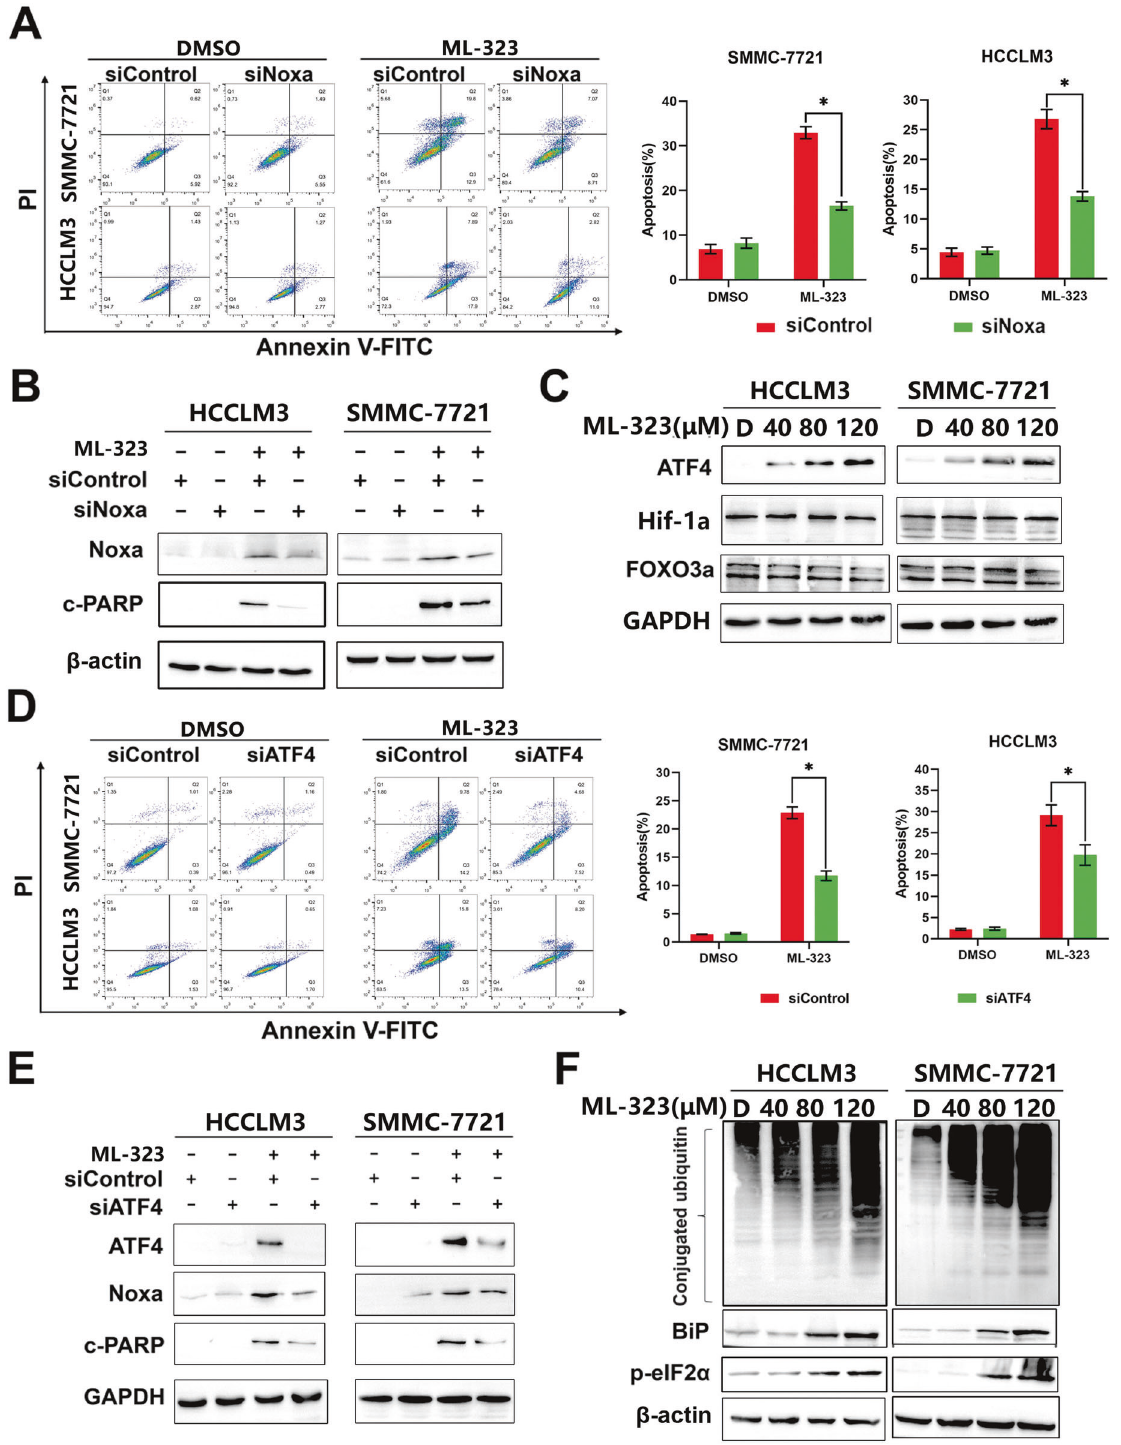
Fig. 3 ML-323 induces hepatocarcinoma cancer (HCC) cell apoptosis via the ATF4-Noxa axis. A Annexin V-FITC /PI double-staining showing apoptotic Noxa-de fi cient HCC cells treated with ML-323. HCCLM3 and SMMC-7721 cells were transfected with control siRNA or Noxa siRNA and then treated with ML-323 for 48 h. B Western blot analysis showing the ef fi ciency of siNoxa and its effects on cleaved-PARP levels. HCCLM3 and SMMC-7721 cells were treated as shown in ( A ). C Western blot analysis of Noxa-related transcription factors. HCCLM3 and SMMC- 7721 cells were treated with DMSO or ML-323, and cell lysates were analyzed by western blotting using speci fi c antibodies. D Annexin V-FITC /PI double-staining of ATF4-de fi cient HCC cells treated with ML-323. After transfection with control or ATF4 siRNA, HCCLM3 and SMMC-7721 cells were treated with ML-323 for 48 h. E Western blot analysis of the knockdown ef fi ciency of siATF4 and its effect on the expression of Noxa and cleaved-PARP. F Western blot analysis of ubiquitinated proteins and ER stress-related proteins. HCCLM3 and SMMC-7721 cells were treated with ML-323. All the data represent at least three independent experiments ( n = 3; error bars, SD). All data represented at least three independent experiments ( n = 3; Error bars, SD).